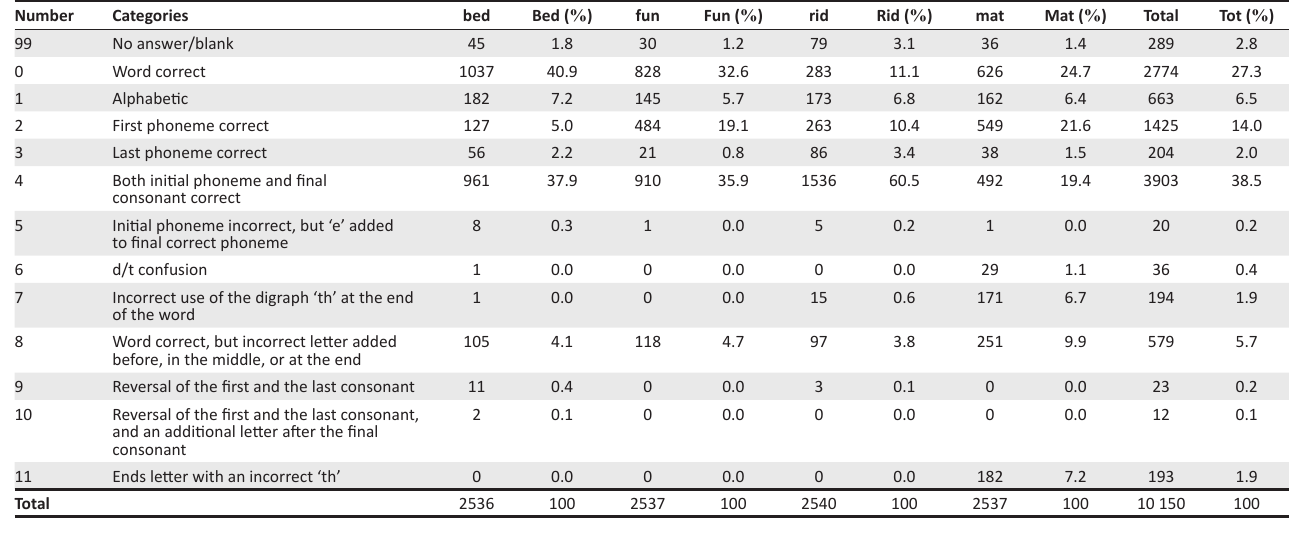
TABLE 1: Aggregates from the error categories ( N = 2536–2540).